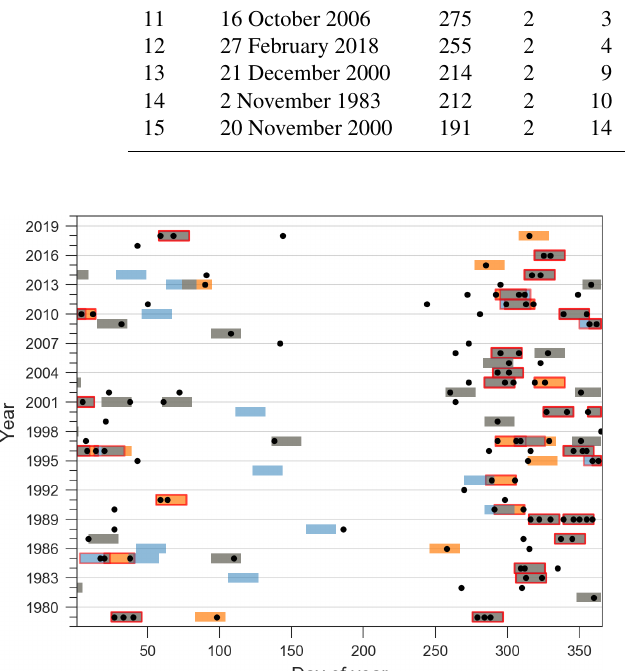
Figure 4. For the catchment 2060654920, all extreme events are shown as black dots, and 21d episodes are highlighted by the coloured rectangles. Episodes appearing in both classifications are shown in grey, and those appearing only in the Cl n classification are shown in orange, whereas those only in the Cl acc classifica- tion are shown in blue. Episodes containing two or more extreme events ( n w ≥ 2) are highlighted with a red edge. The clustering and contribution metrics (see Sect. 2.4) for this catchment are re- spectively S cl = 43 . 63 and S cont = 0 . 89, indicating prevalent sub- seasonal clustering with a substantial contribution to large accumu- lations (similar to the catchment of Appendix